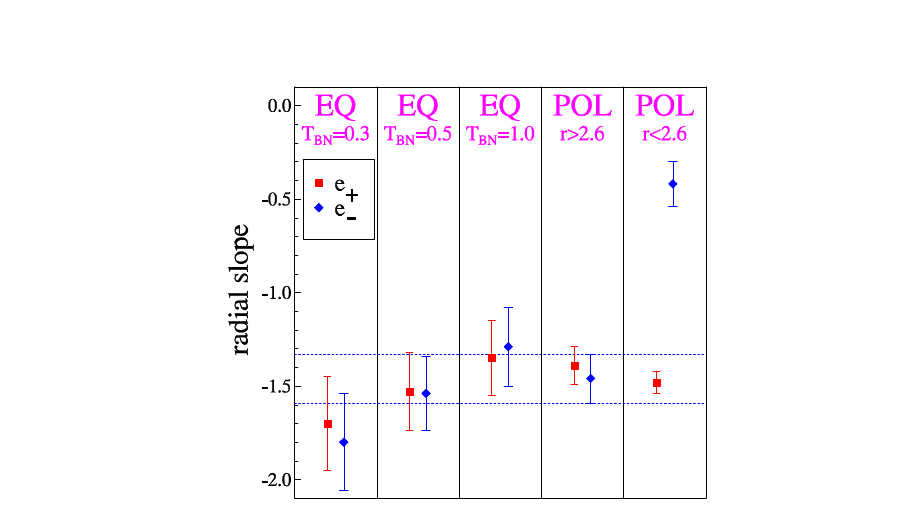
Figure 66: e + (red) and e – (blue) radial gradient for different latitudinal regions of the solar wind. The first three columns, labeled EQ, refer to ecliptic observations obtained with different values of the upper limit of TBN defined as the relative fluctuations of density and magnetic intensity. The last two columns, labeled POL, refer to observations of polar turbulence outside and inside 2.6 AU, respectively. Image reproduced by permission from Bavassano et al. (2001), copyright by